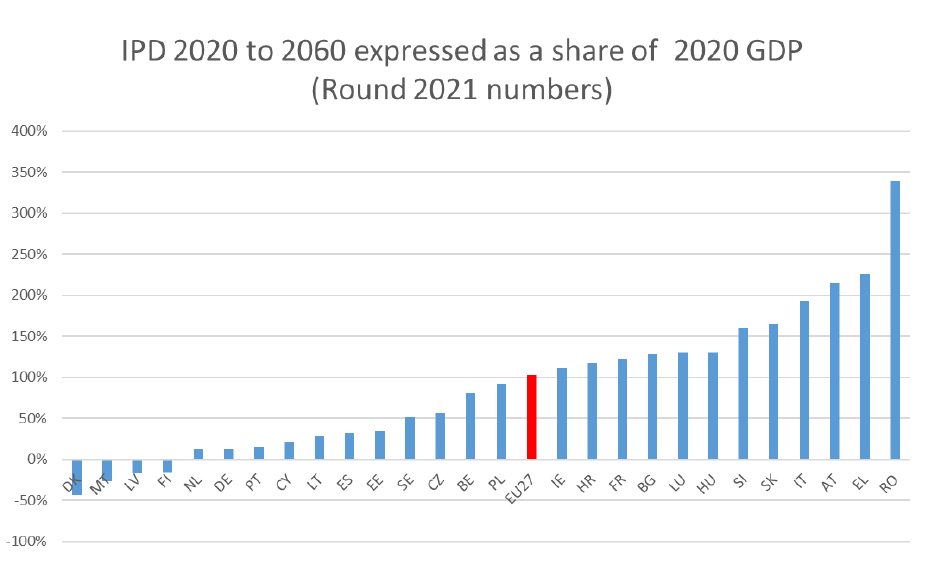
Figure 2. IPD 2020–2060 expressed as a share of GDP, 2020.